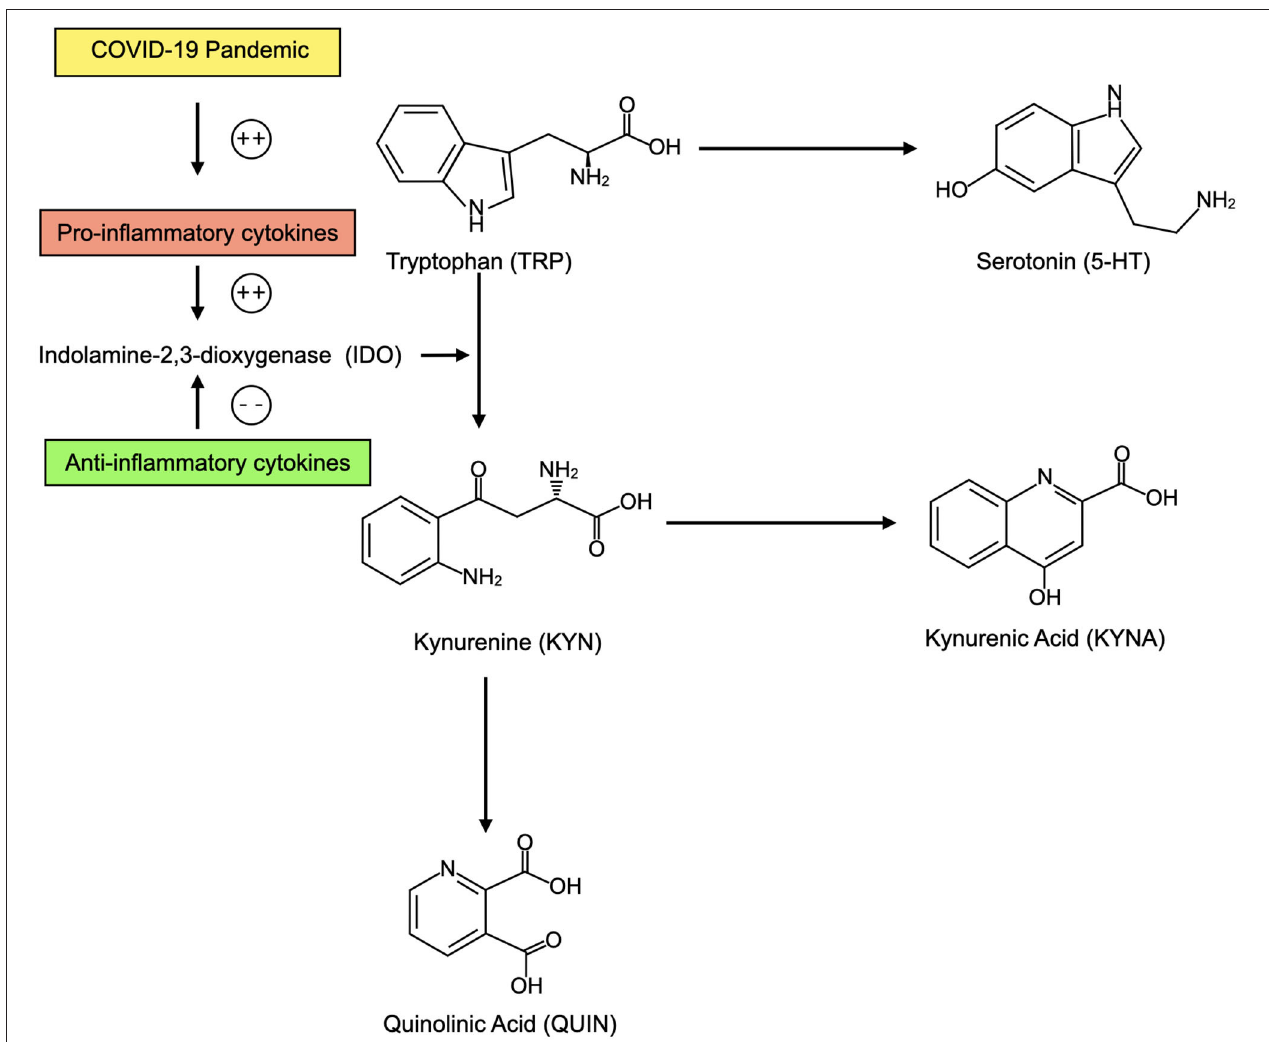
FIGURE 3 | In the context of elevated inflammatory cytokines as a result of the COVID-19 pandemic, CNS tryptophan (TRP) may be preferentially converted into kynurenine (KYN) and its metabolites including kynurenic acid (KYNA) and quinolinic acid (QUIN). This may decrease availability of serotonin (5-HT). KYN metabolites may also contribute to depression. When anti-inflammatory cytokines are present, TRP may be preferentially converted into